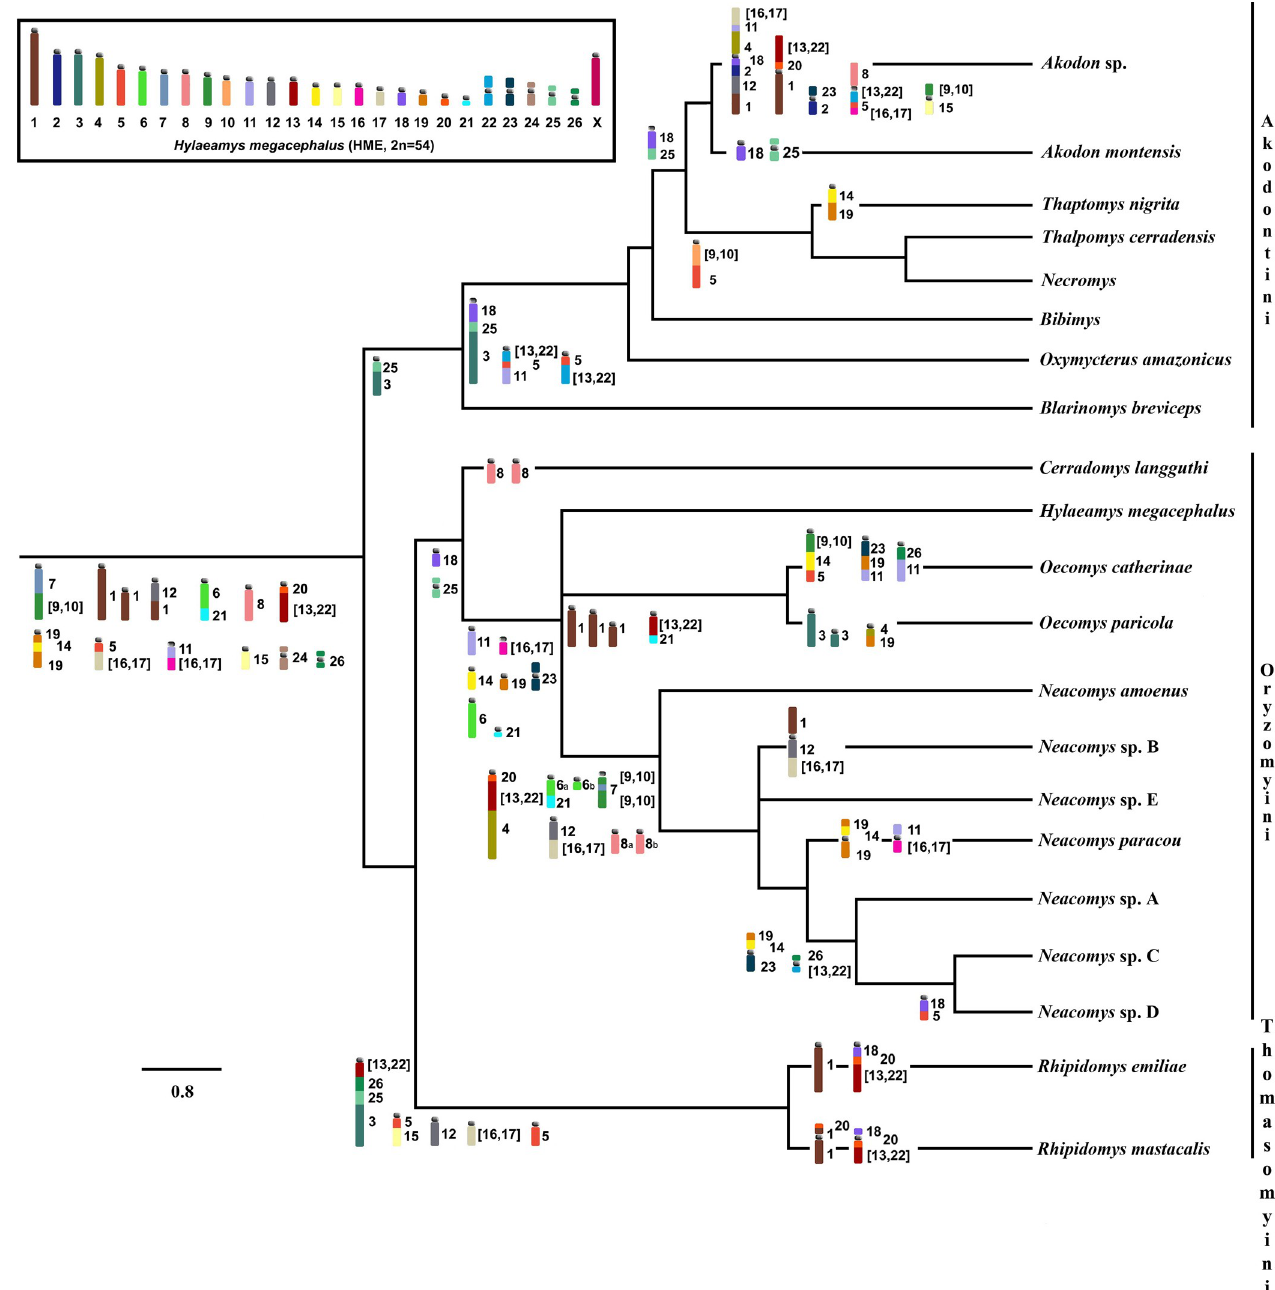
Fig 7. Chromosomal evolution in the tribes Oryzomyini, Akodontini, and Thomasomyini. The phylogeny was based on [40] and [41]. The chromosomes colors and morphology refer to the HME karyotype inside the box is the idiogram of the HME karyotype [41], from which the whole chromosome probes were